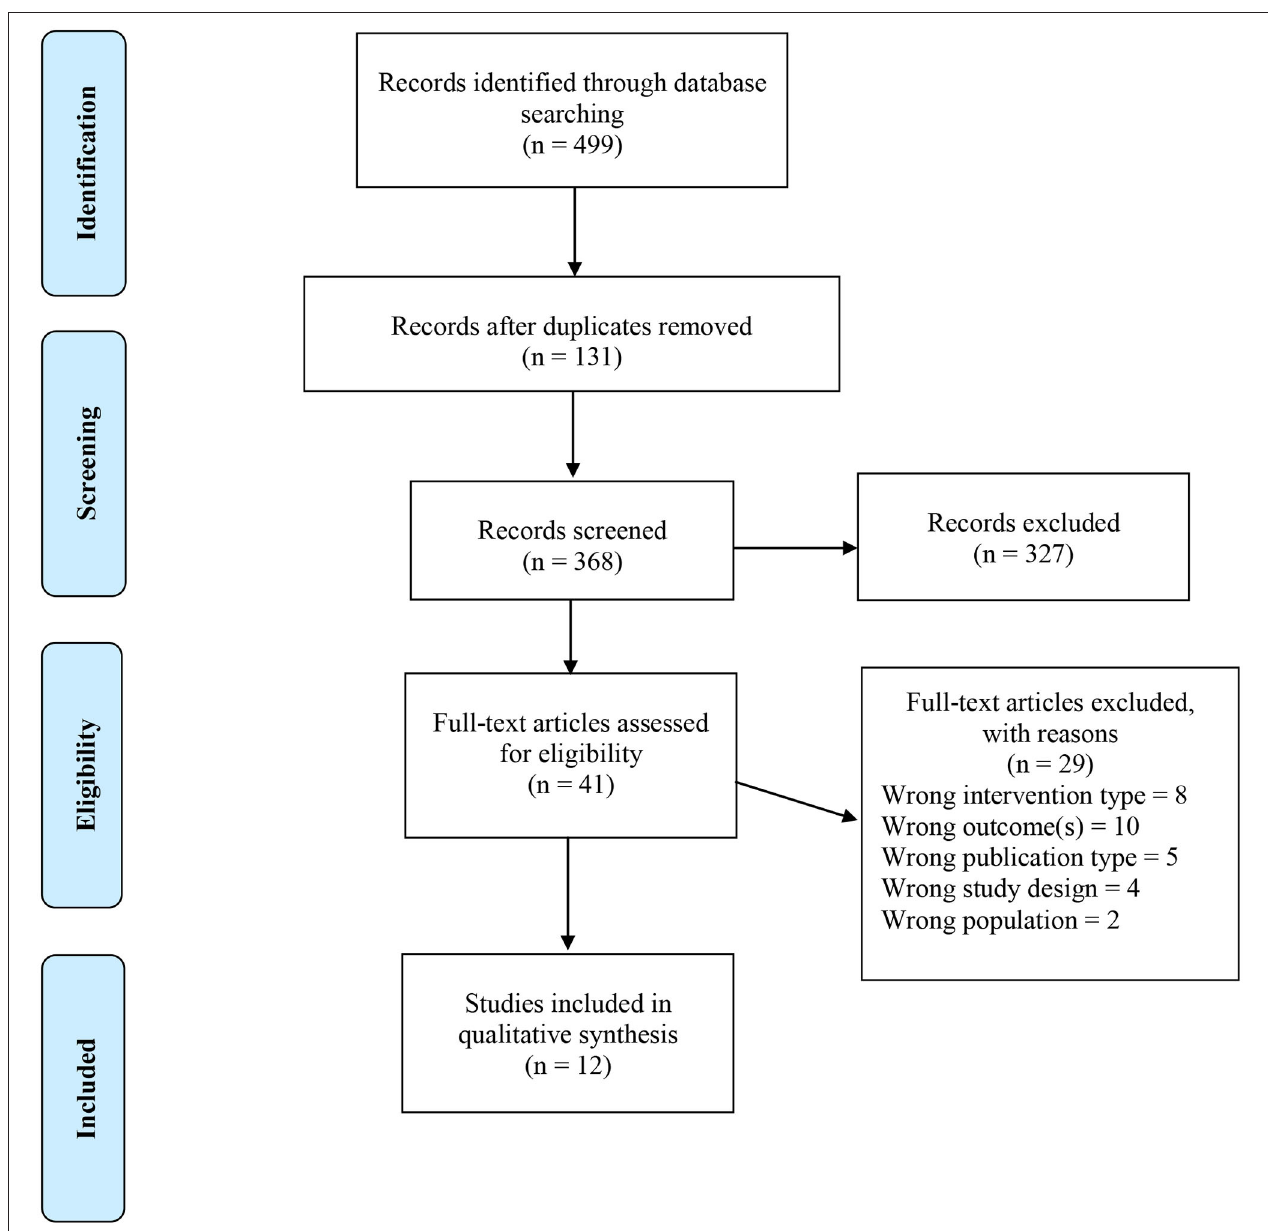
FIGURE 1 | Study selection flow